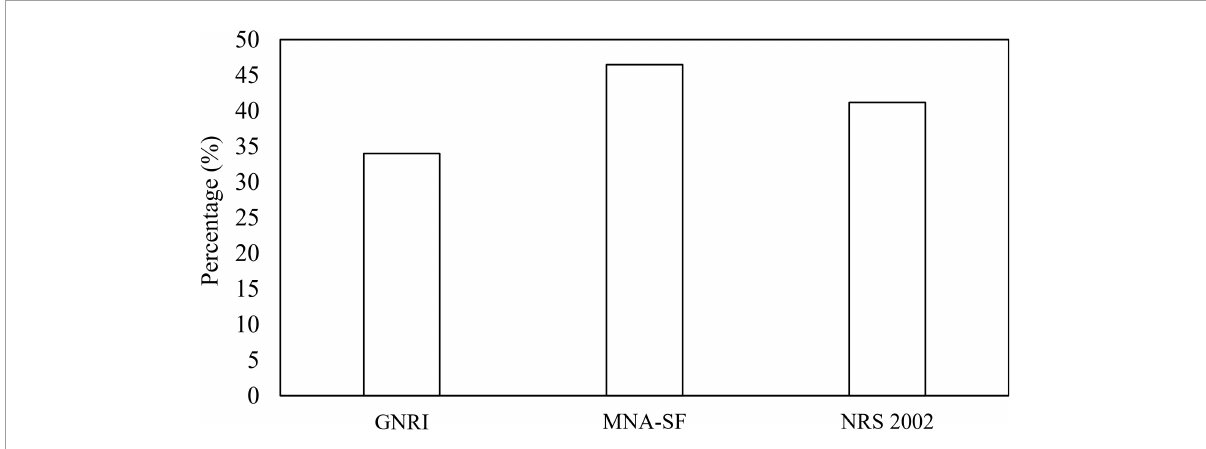
FIGURE1 Classification of malnutrition risk based on GNRI, MNA-SF, and NRS 2002. GNRI, geriatric nutritional risk index; MNA-SF, mini nutritional assessment-short form; NRS, nutritional risk screening.